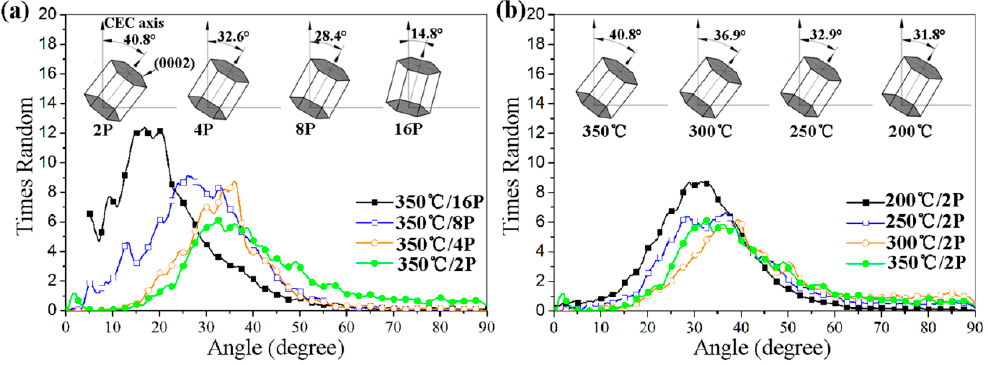
Figure 7. {0002} pole plot of CECed ZK61 alloy at ( a ) 350 °C and ( b ) 2P.